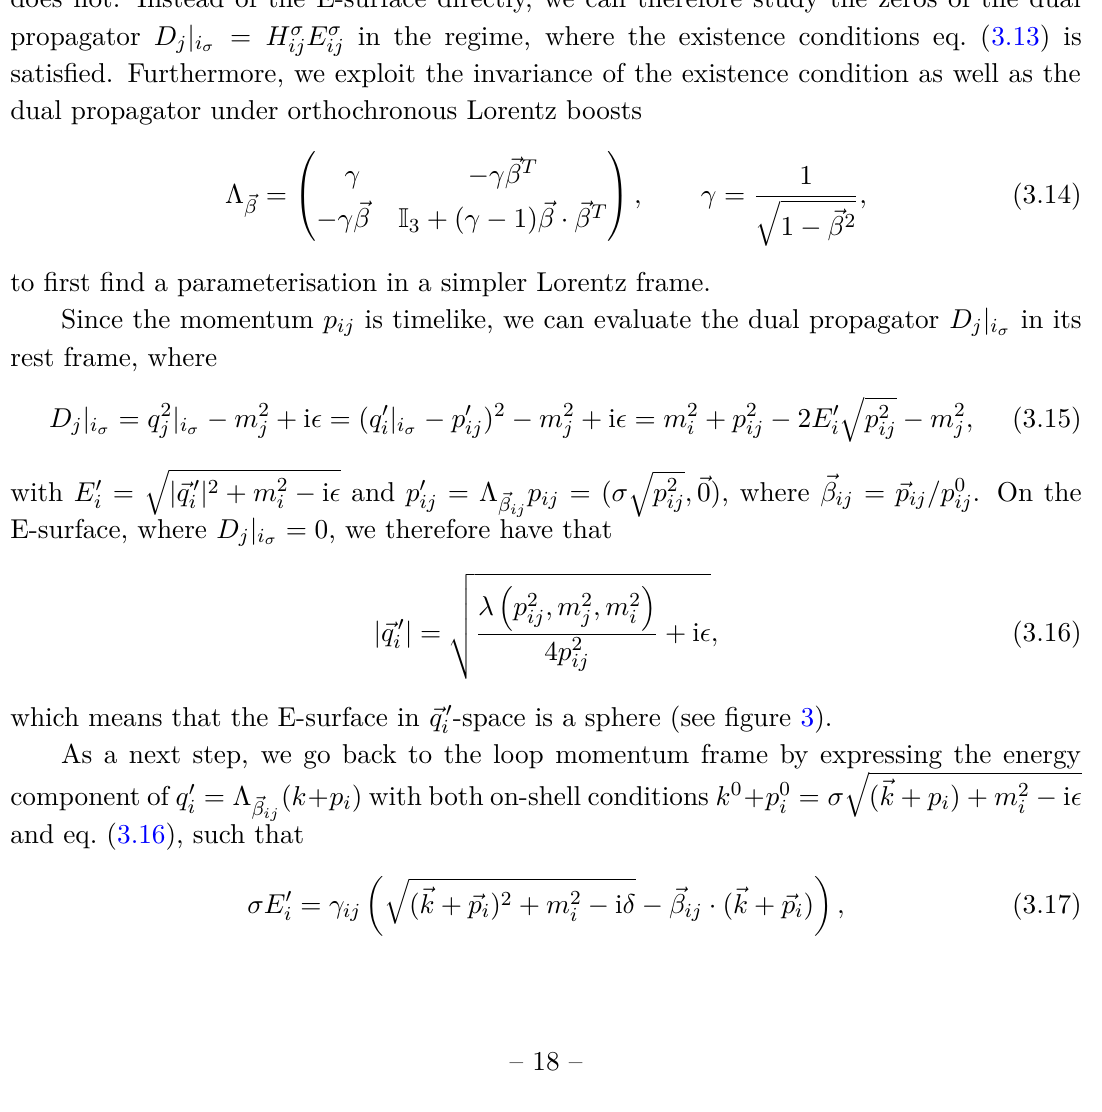
. Note that in ij (ˆ k ) i σ j − σ